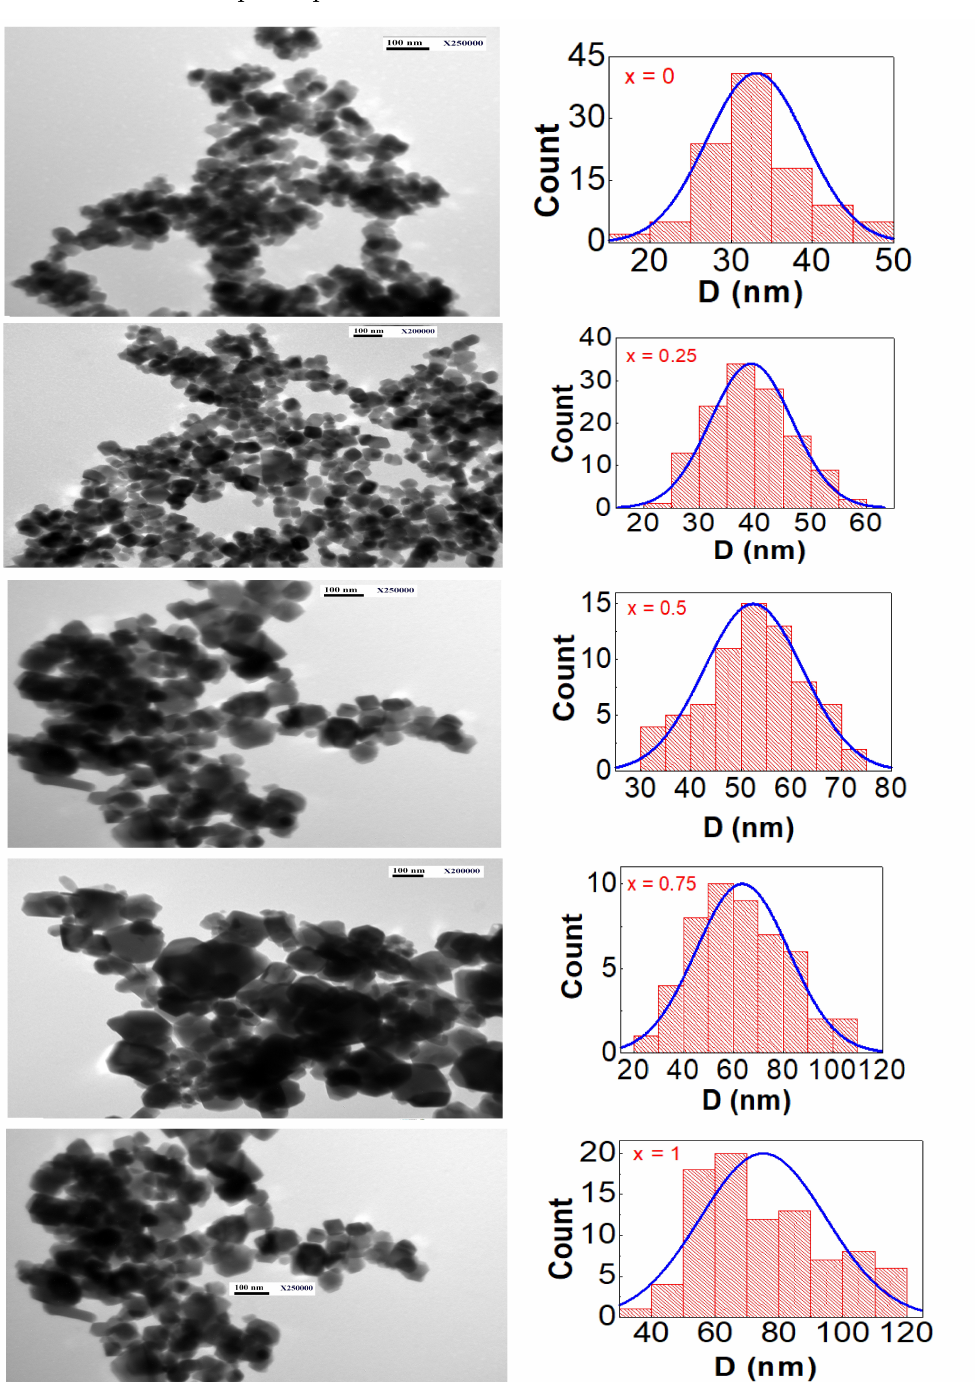
Figure 4. TEM images and particle size distribution histograms for the Ni x Co 1 − x Fe 2 O 4 spinel ferrites with 0 ≤ x ≤ 1. Starting at the top (x = 0, 0.25, 0.5, 0.75,